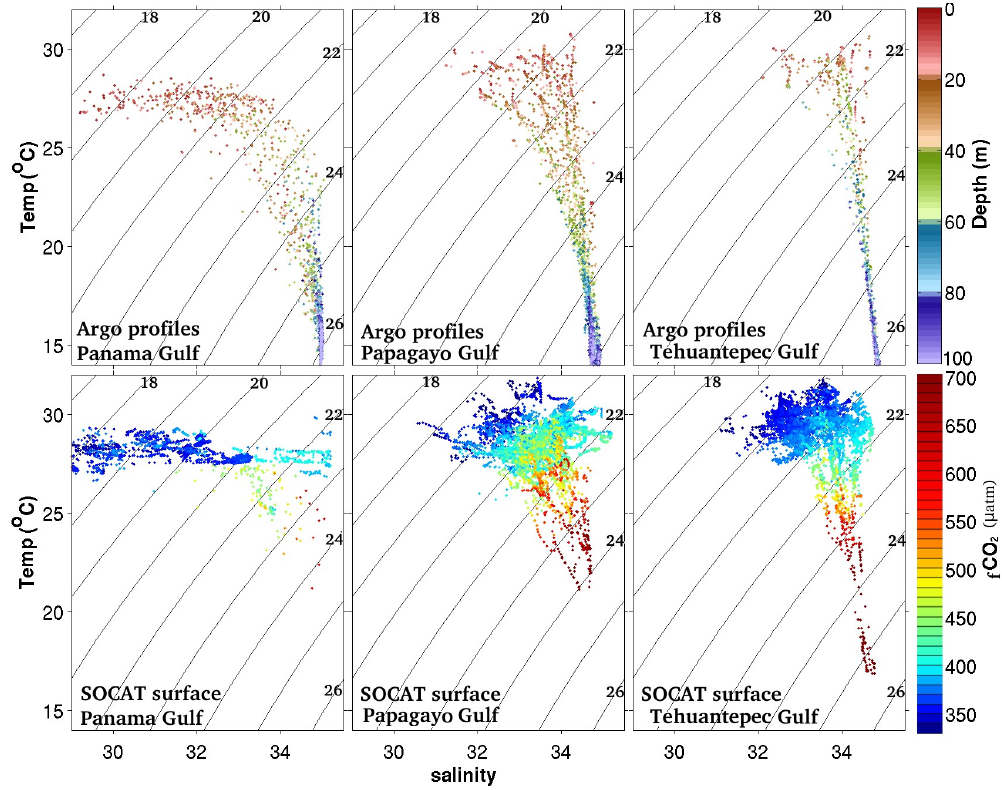
Figure 4. T S data from the three main gulfs within the ETPO both from Argo floats (coloured according to depth – top three plots) and from surface SOCAT T and S data, (coloured according to level of f CO 2 – bottom three